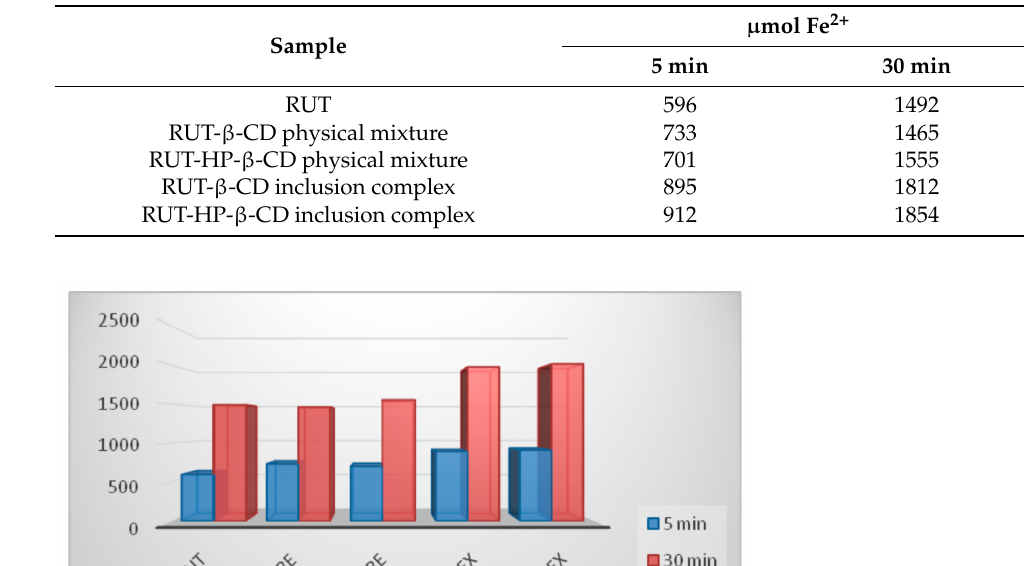
Table 5. FRAP values of the studied samples.